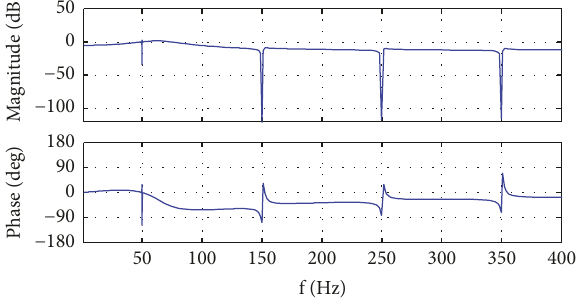
Figure 10: The bode diagram of 𝑋 𝑢 (𝑠)